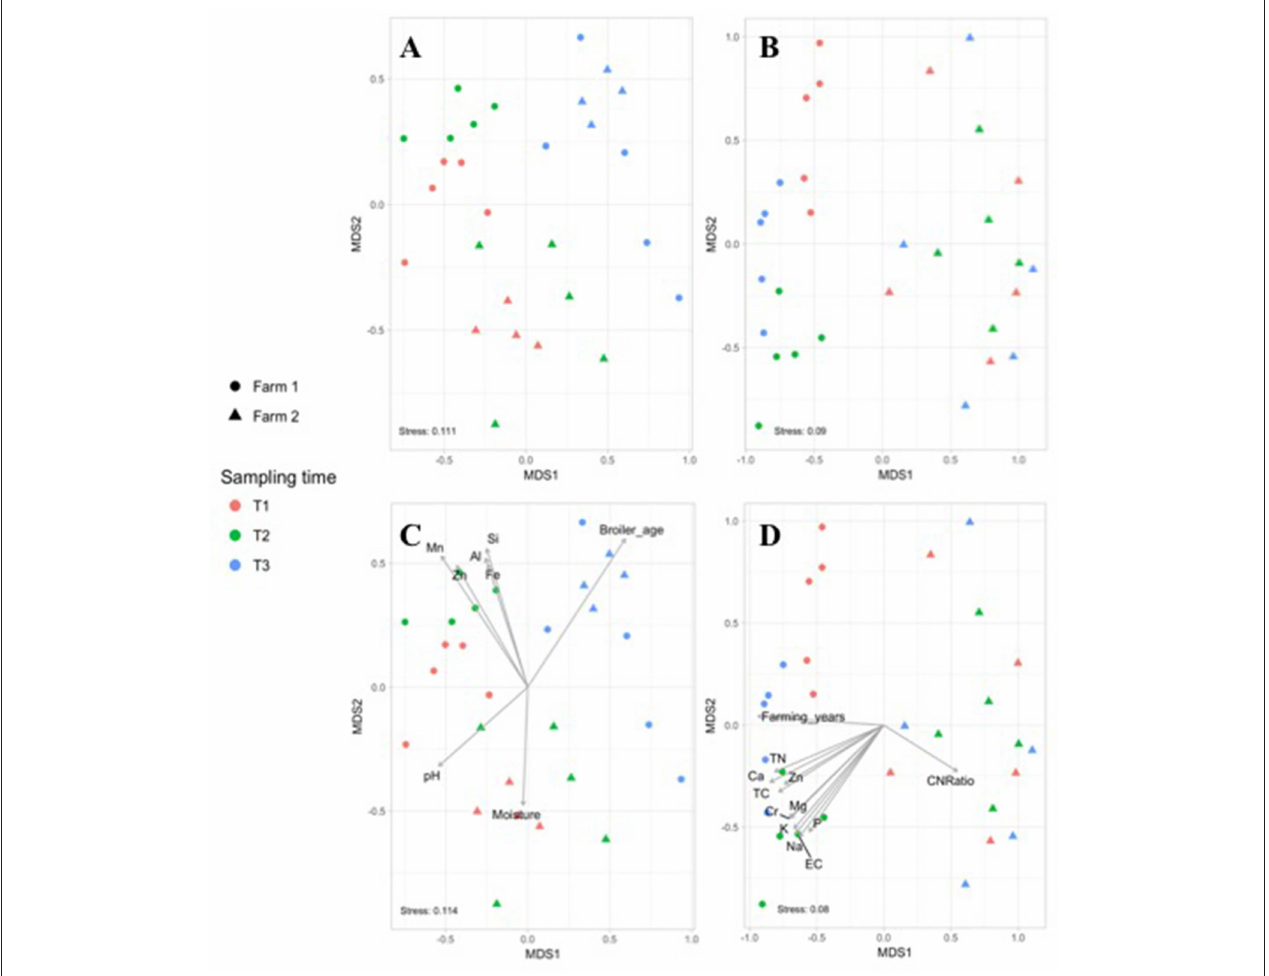
FIGURE 1 | Non-metric multidimensional scaling (NMDS) based on Bray–Curtis dissimilarities of bacterial community composition from fecal (A) and soil (B) samples collected in farm 1 (circle) and 2 (triangle) during the live production stage at T1 (red), T2 (green), and T3 (blue). Significant farm parameters ( p < 0.01) were fitted onto the NMDS plot using the envfit function in the VEGAN package for the fecal (C) and soil (D) microbiomes.